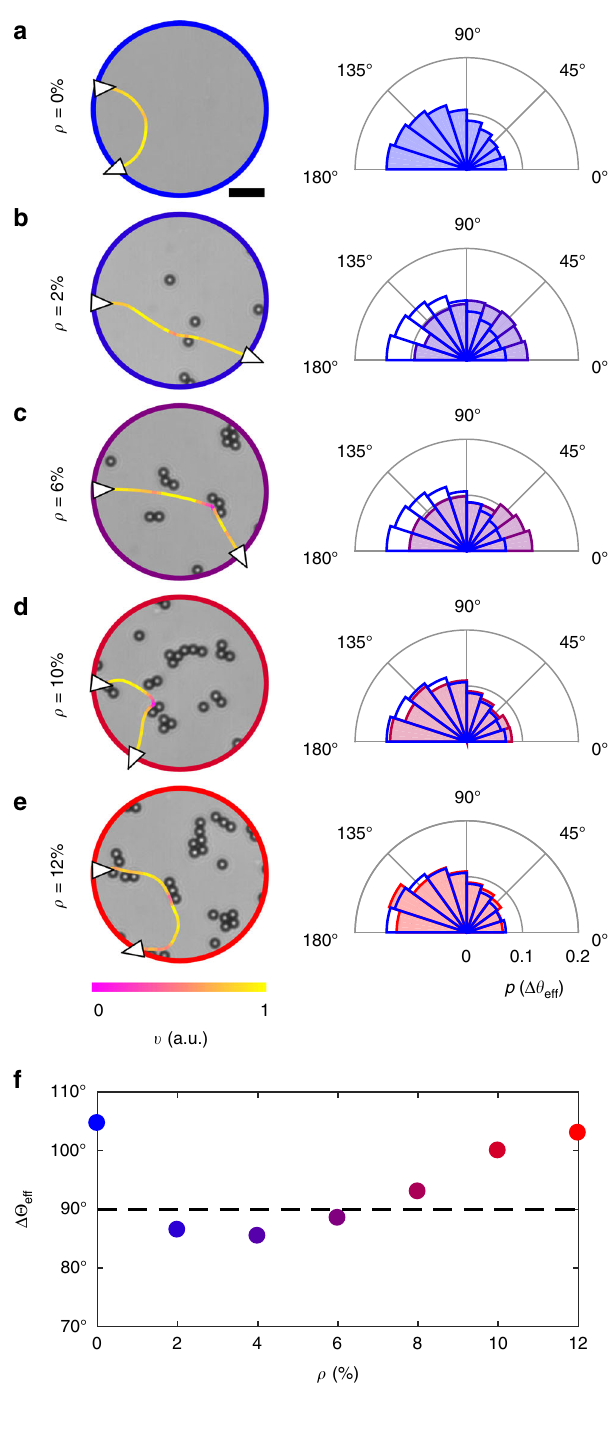
direction of motion θ change near the obstacles (Supplementary Fig. 3a – d and Methods). Their detailed analysis offers a micro- scopic explanation for the previous experimental observations (Figs. 1 and 2). During forward-scattering events (Fig. 3a and Supplementary Fig. 3a, c), cells tend to approach the obstacles almost tangentially (Supplementary Fig. 3e) and their trajectories show minimal changes in speed and direction of motion, con- sistently with previous theoretical proposals 45 . Instead, during tumble-collisions (Fig. 3b and Supplementary Fig. 3b, d), more cells tend to approach the obstacles nearly head-on (Supple- mentary Fig. 3e), their speed drops signi fi cantly and they tend to